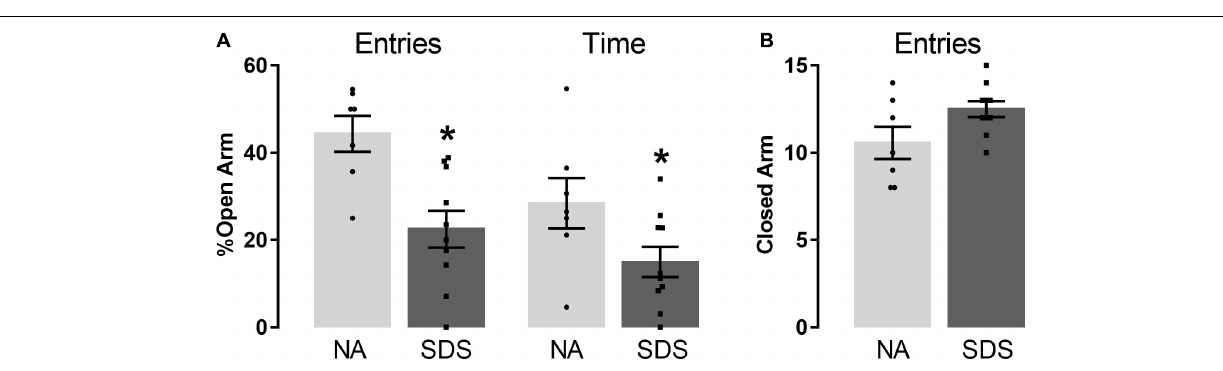
FIGURE 2 | Chronic social defeat stress induces anxiety-like behavior in mice. (A) percentage of open-arm entries and percentage of open-arm time in the EPM. (B) Frequency of closed-arm entries in the EPM. Bars with scatter dot plot represent mean ( ± SEM). n = 7–10. * p < 0.05 compared with the NA group. NA, non-aggressive; SDS, social defeat stress; EPM, elevated plus